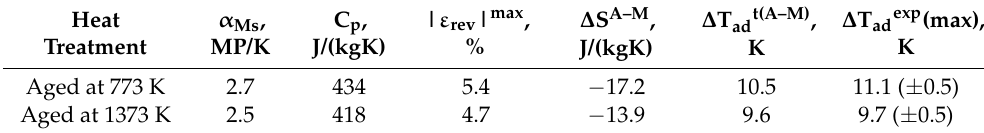
Table 2. Maximum theoretical ∆ T adt(A–M) , calculated by Equations (1) and (2), and